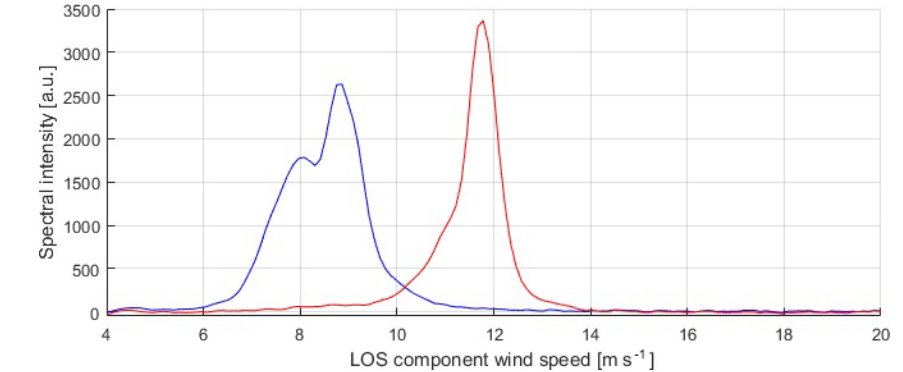
Figure 6. Example of two lidar Doppler spectra gathered during the same 1min interval. The red spectrum is measured in the free flow, while the blue spectrum is affected by a wake. For the blue spectrum, the reduced wind speed and increased spectral width can clearly be seen. The spectra are averaged over 1min.